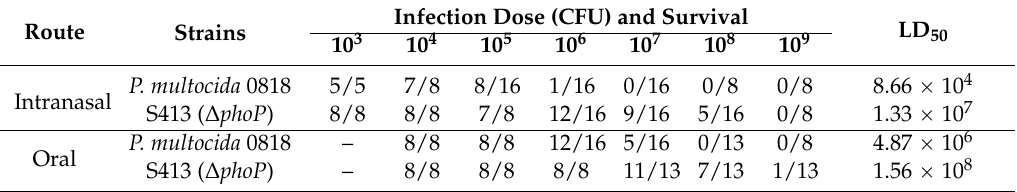
Table 1. Determination of the LD 50 of P. multocida 0818 and the ∆ phoP mutant. Route Strains